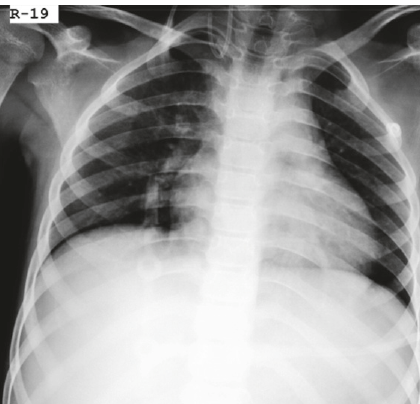
Figure 1: The catheter can be seen looping back and going upward at the junction of the right internal jugular vein and the right subclavian vein.